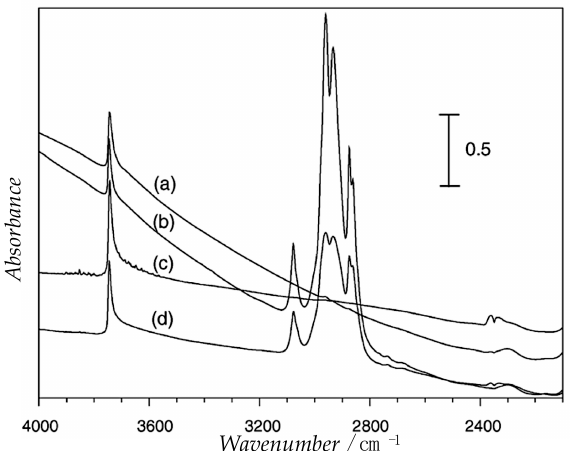
Figure 10. FT-IR spectra of Ti-MFI-MW (a) before and (b) after 1-hexene adsorption and Ti-MFI-CH (c) before and (d) after 1-hexene adsorption. Adapted from Reference [15].